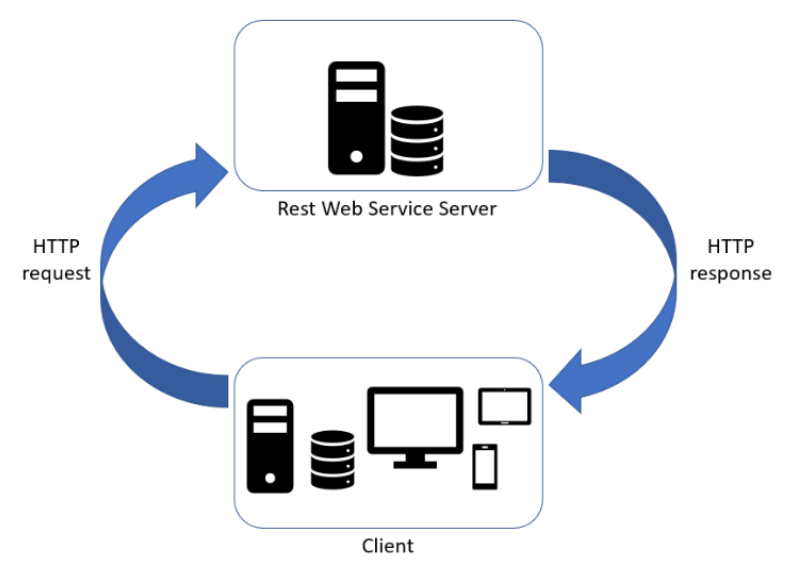
Figure 4. REST API synchronous communication schema.